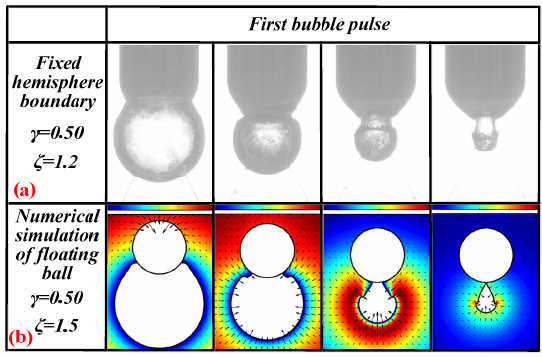
Figure 10. ( a ) The bubble’s morphological changes under the influence of ζ = 1.2 and γ = 0.50. ( b ) Numerical simulation of the bubble’s morphological changes. The pictures are quoted from [17].